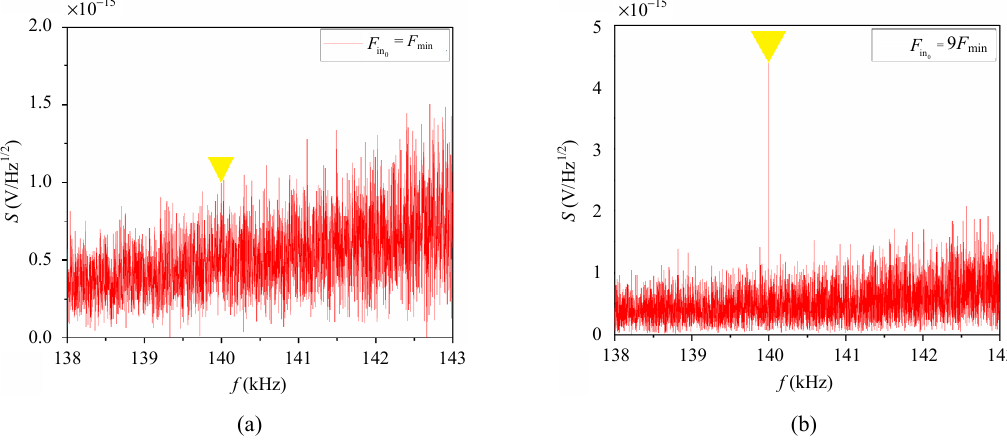
Fig. 9 Power spectral density curve when f BW is constant: